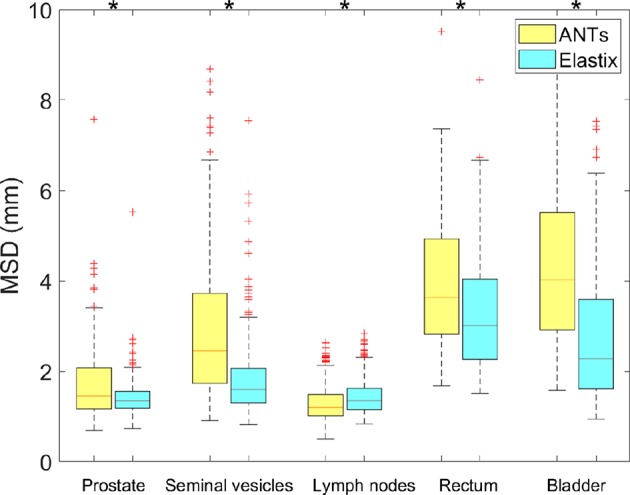
Boxplot of MSD from elastix DIR 100 iterations compared to ANTs for different organs. Star above boxes means a statistical difference of a Wilcoxon signed-rank test between the two methods.